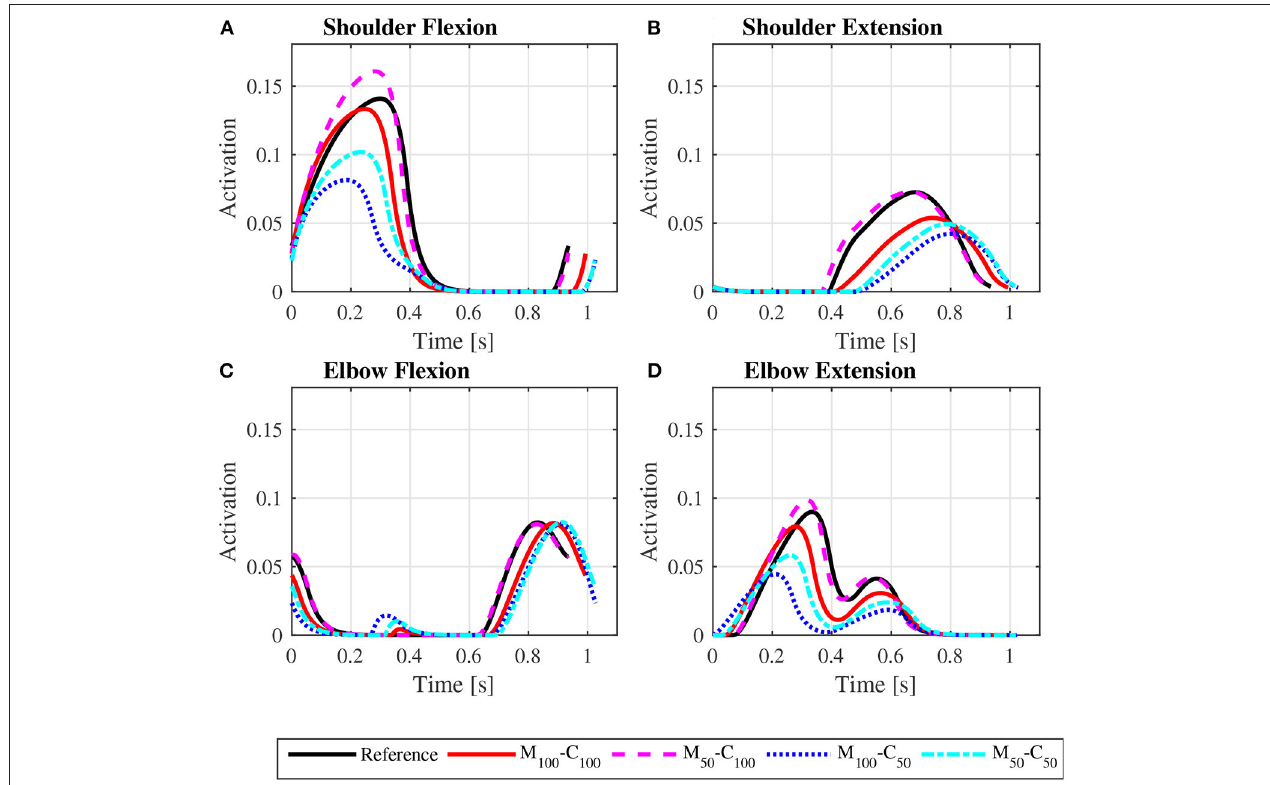
FIGURE 8 | Predicted shoulder flexion (A) , shoulder extension (B) , elbow flexion (C) and elbow extension (D) activation profiles along a complete cycle for steady state locomotion on a level surface at an average speed of 0.9 m/s for the reference unassisted condition (Reference), and for the assisted locomotion with 100% of reference model parameters Mi and Ci ( M 100 − C 100 ), reduction of 50% in Mi ( M 50 − C 100 ), reduction of 50% in Ci ( M 100 − C 50 ), and reduction of 50% in Mi and Ci ( M 50 − C 50